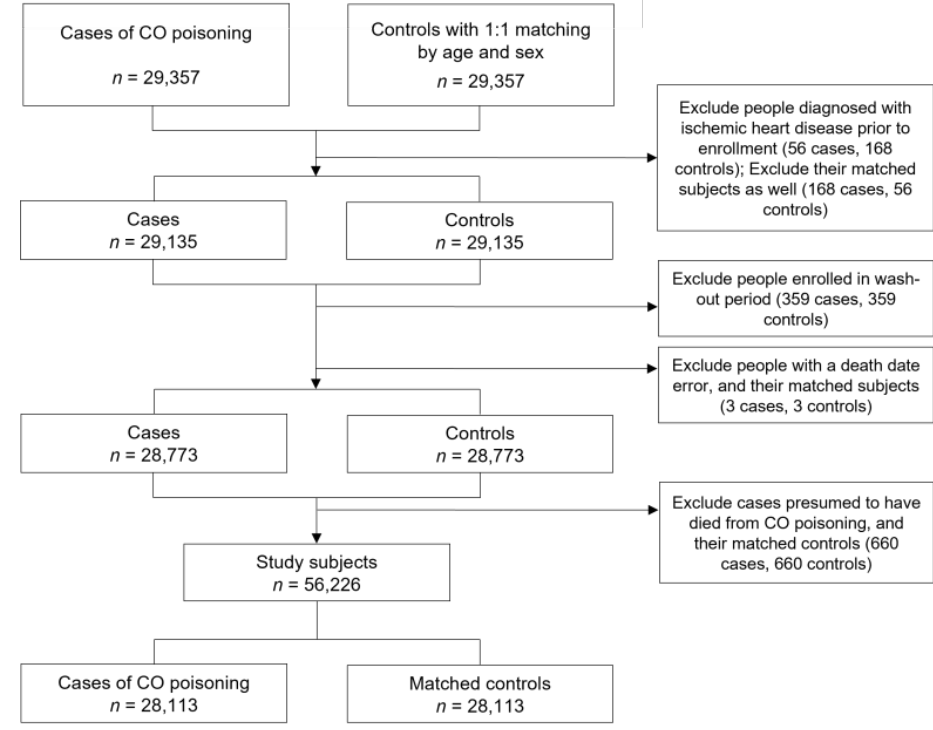
Figure 1. Flowchart for the selection of the study population.